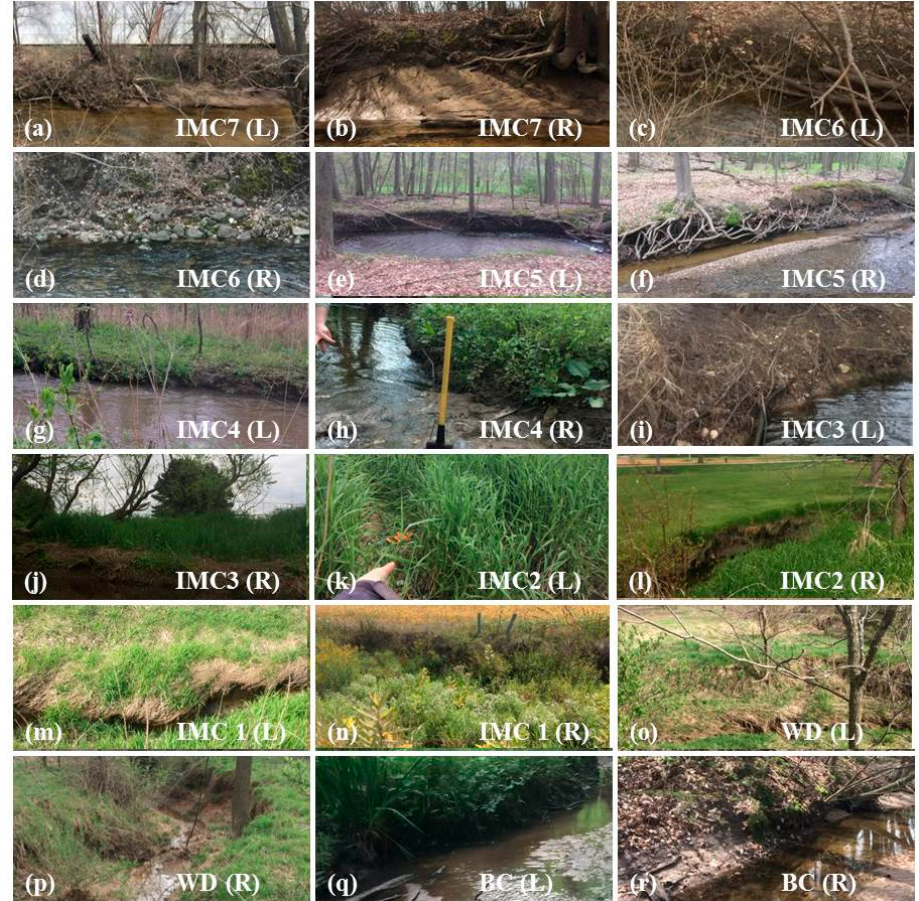
Figure 4. Photos of the 18 study streambanks in the Indian Mill Creek watershed, labeled by figure letter, site and left (L) or right (R) bank. Photos ( a ) through ( h ) are in the lower watershed through urban and forested land cover, ( i ) through ( n ) are in the upper watershed through farmland, and ( o ) through ( r ) are on tributaries.